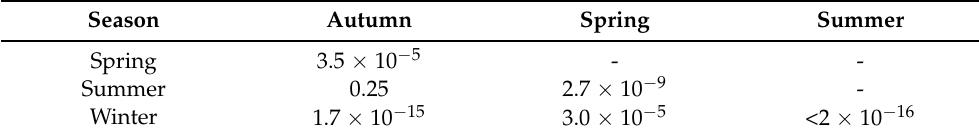
Table 3. Results of season comparisons using t test with pooled SD ( p value adjustment method: bonferroni).